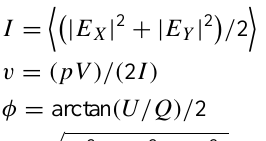
polarization concurrently from two of the Cluster